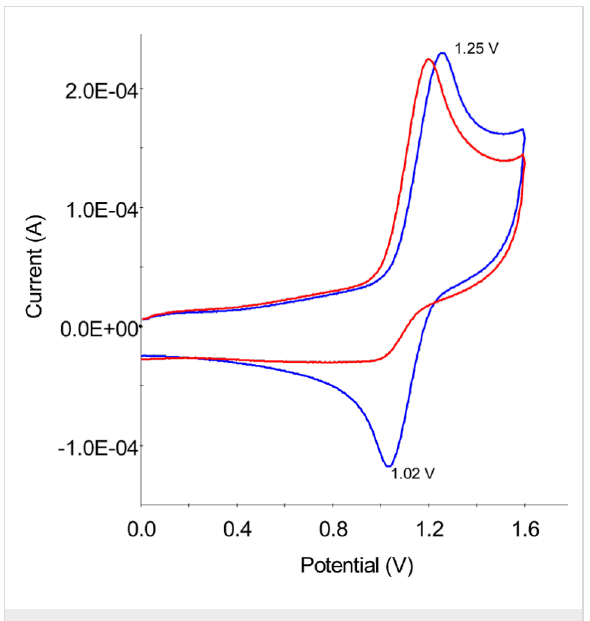
Figure 1: Electrochemical oxidation of 1 in deareated (blue) and O 2 saturated (red) solutions of CH 2 Cl 2 /0.1 M TBAPF 6 , c = 5 × 10 − 4 M.